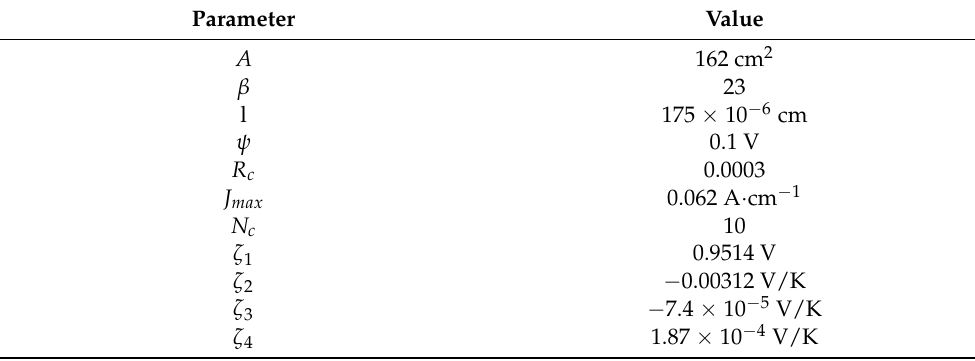
Table 1. The PEMFC model